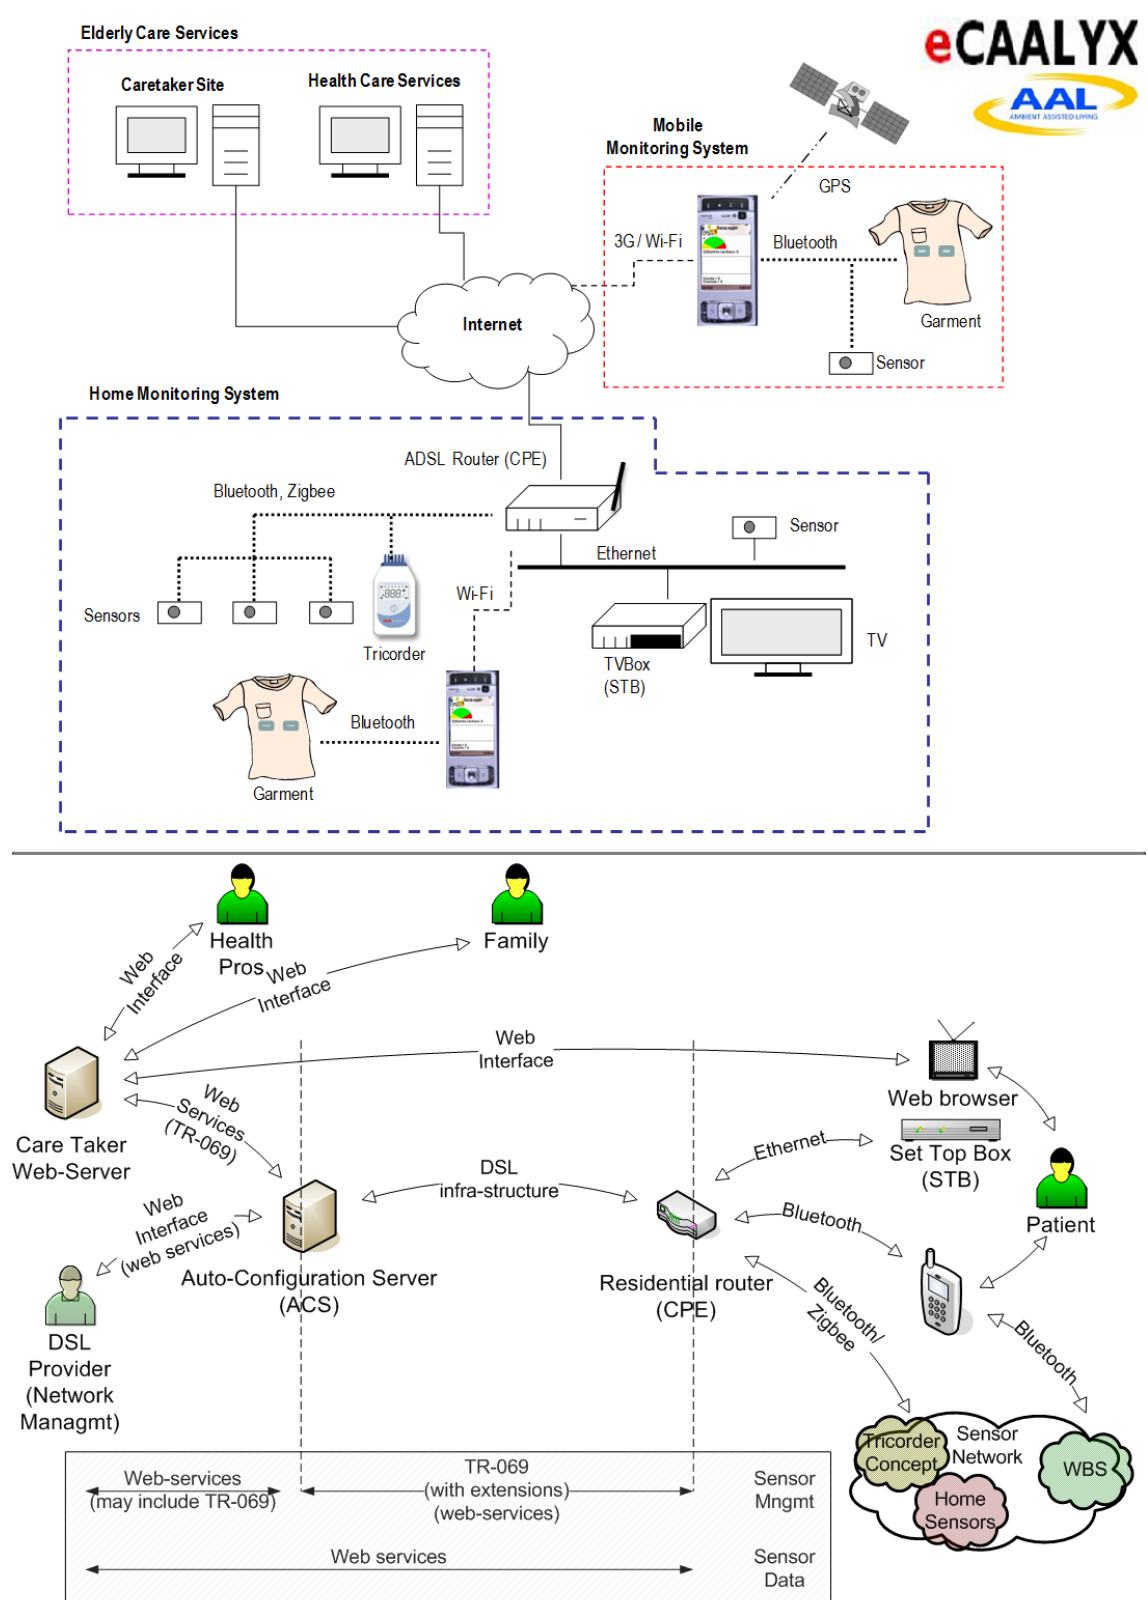
Figure 2. eCAALYX‘s system